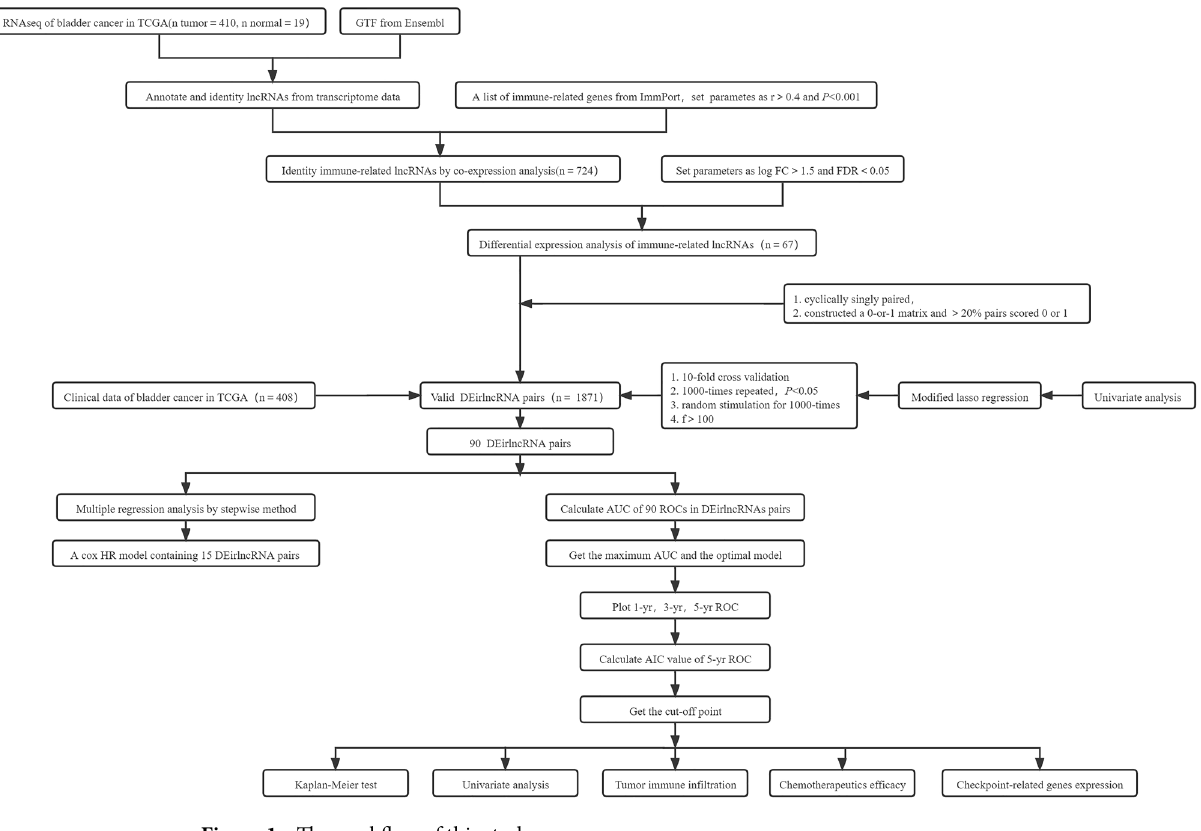
Figure 1. The workflow of this